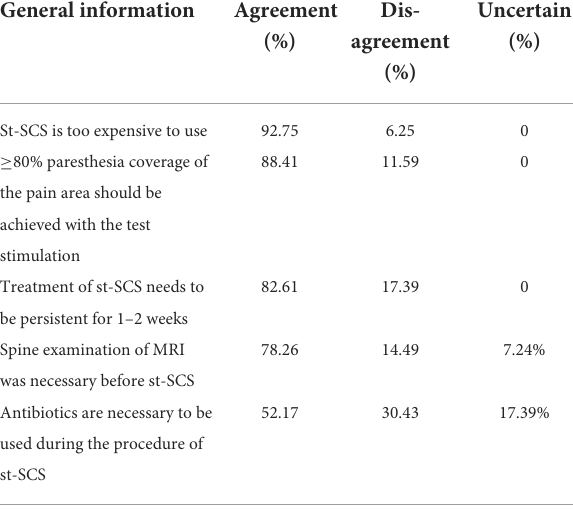
TABLE 2 General information about the procedure of st-SCS. General information